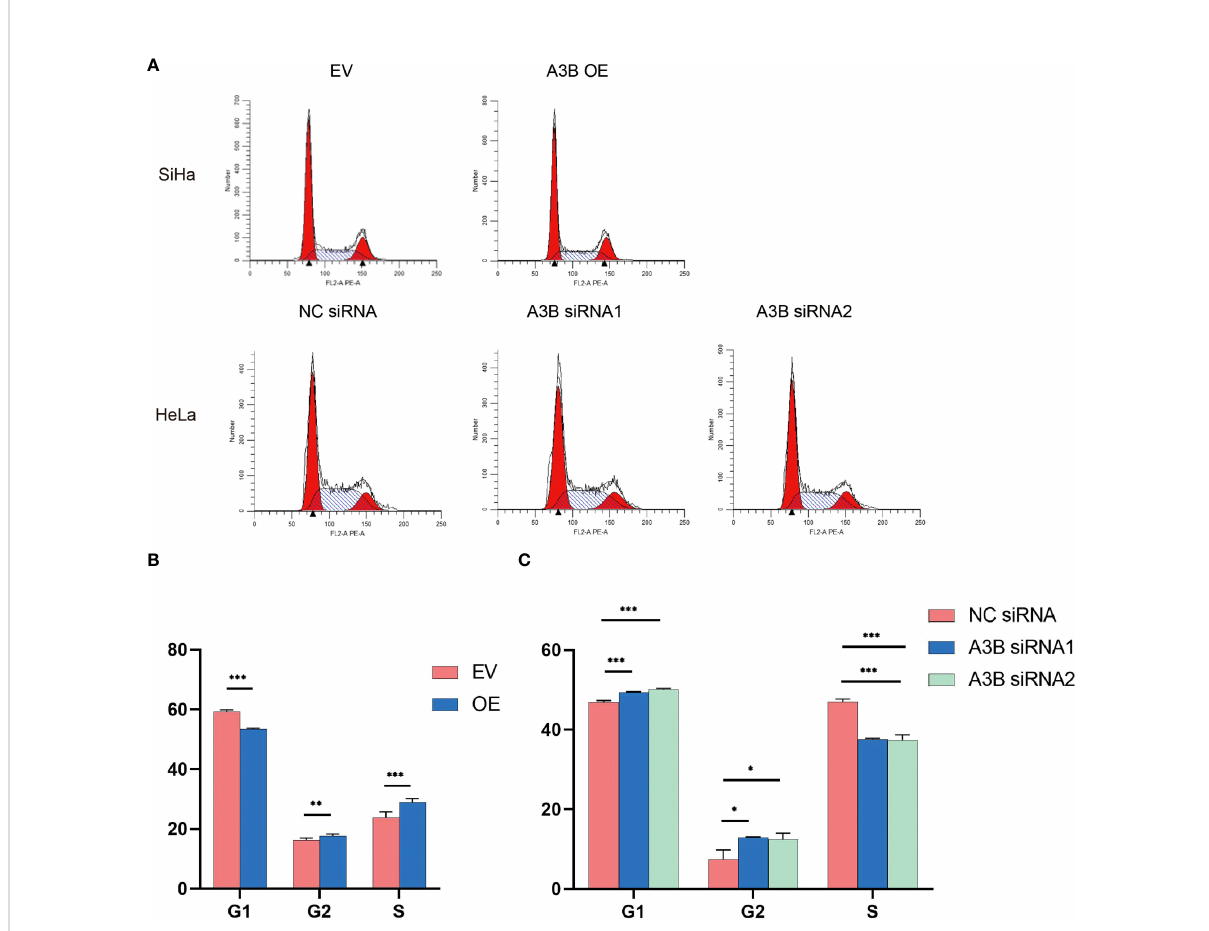
FIGURE 7 Effects of A3B on the number of cervical cancer cells in S- and G2/M-phases. (A) Typical fl ow cytometric analysis of the cell cycle. (B) Statistical analysis of SiHa cells. (C) Statistical analysis of HeLa cells. Apparently, A3B in fl uences cervical cancer cells in the G1-, S-, and G2-phases. * p < 0.05, ** p < 0.01, *** p <